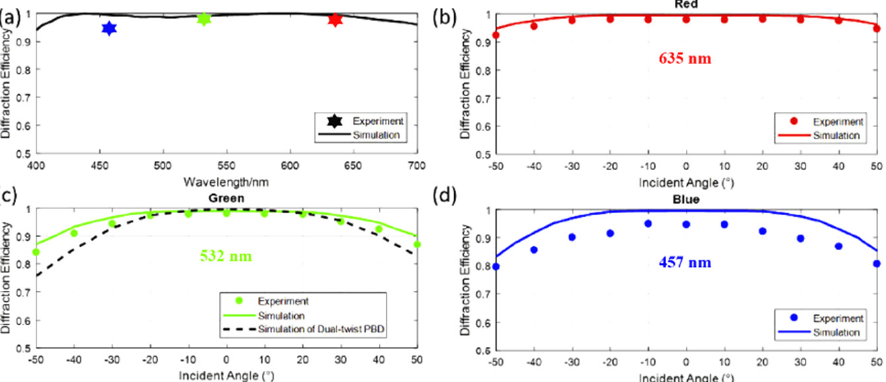
Figure 6. Simulated and measured results: spectral ( a ) and angular response at ( b ) R (635 nm), ( c ) G (532 nm), ( d ) B (457 nm) of the three-layer multi-twist PBD [35]. Adapted with permission from [35] (532 nm), ( d ) B (457 nm) of the three-layer multi-twist PBD [35] . © The Optical